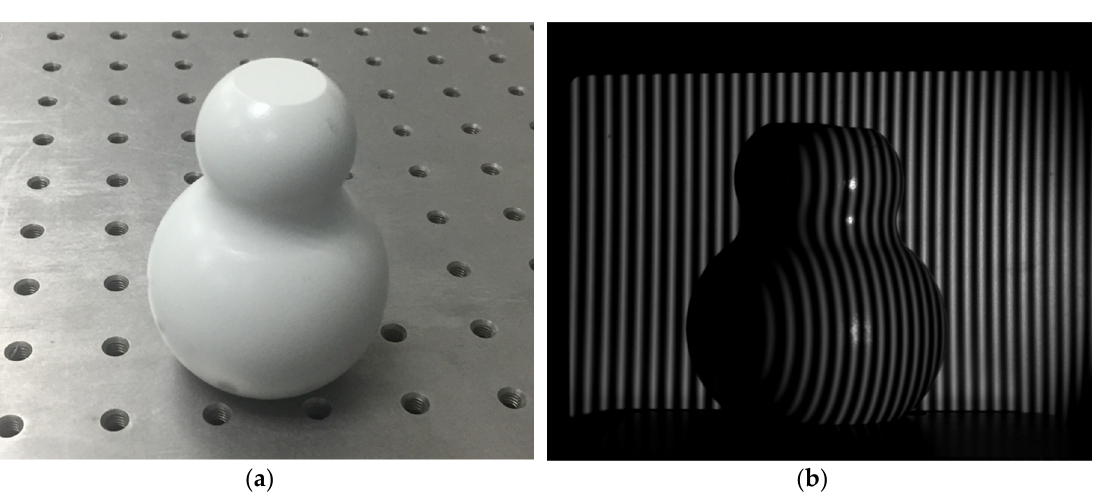
Figure 12. ( a ) Calabash’s phase distribution calculated by machine learning; ( b ) calabash’s phase distribution calculated by FFT.